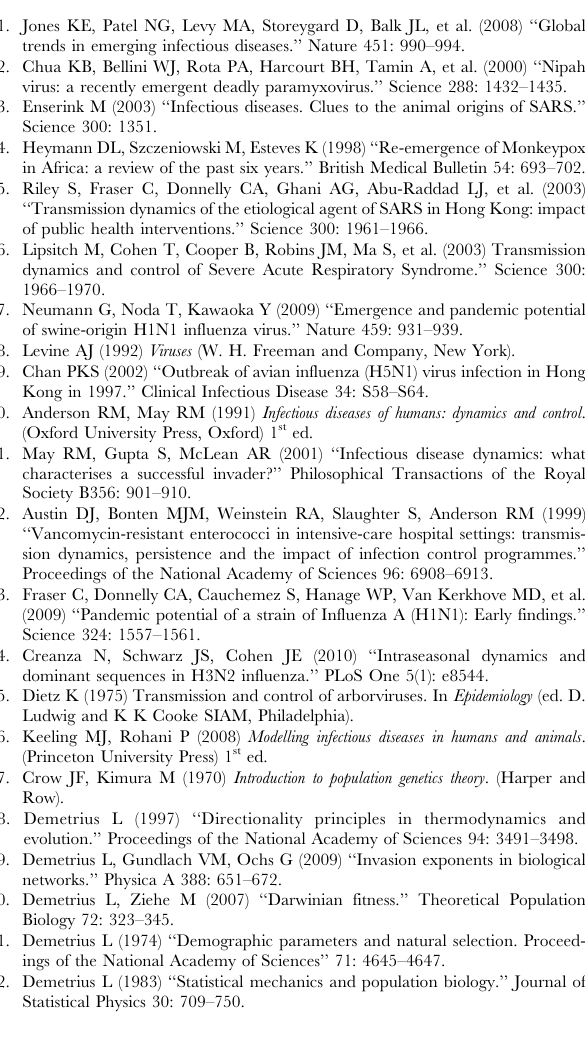
Table S1 Invasion criteria in the entropy model. *‘‘a.s.= Almost surely’’ refers to the fact the result is a stochastic process. The criteria for large and small population size are defined in more detail in Demetrius et al. [19]. The criteria noted in Table S1 have